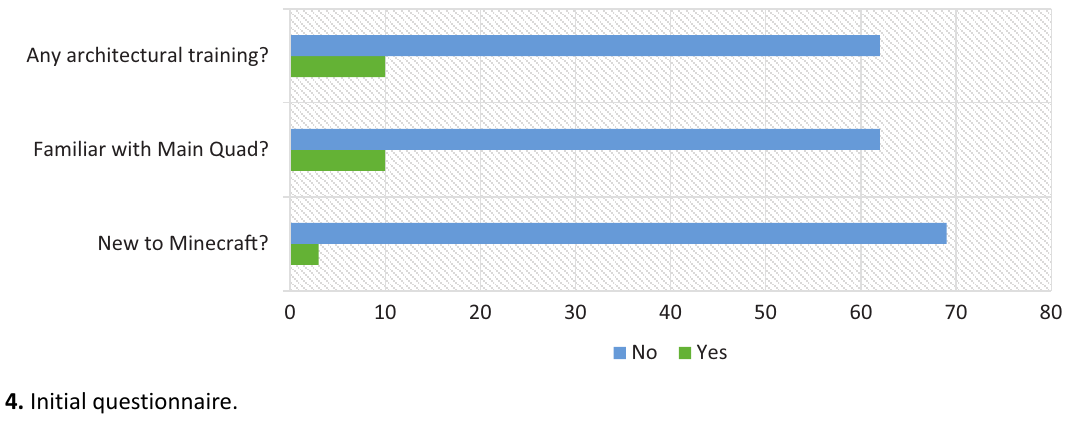
Figure 4. Initial